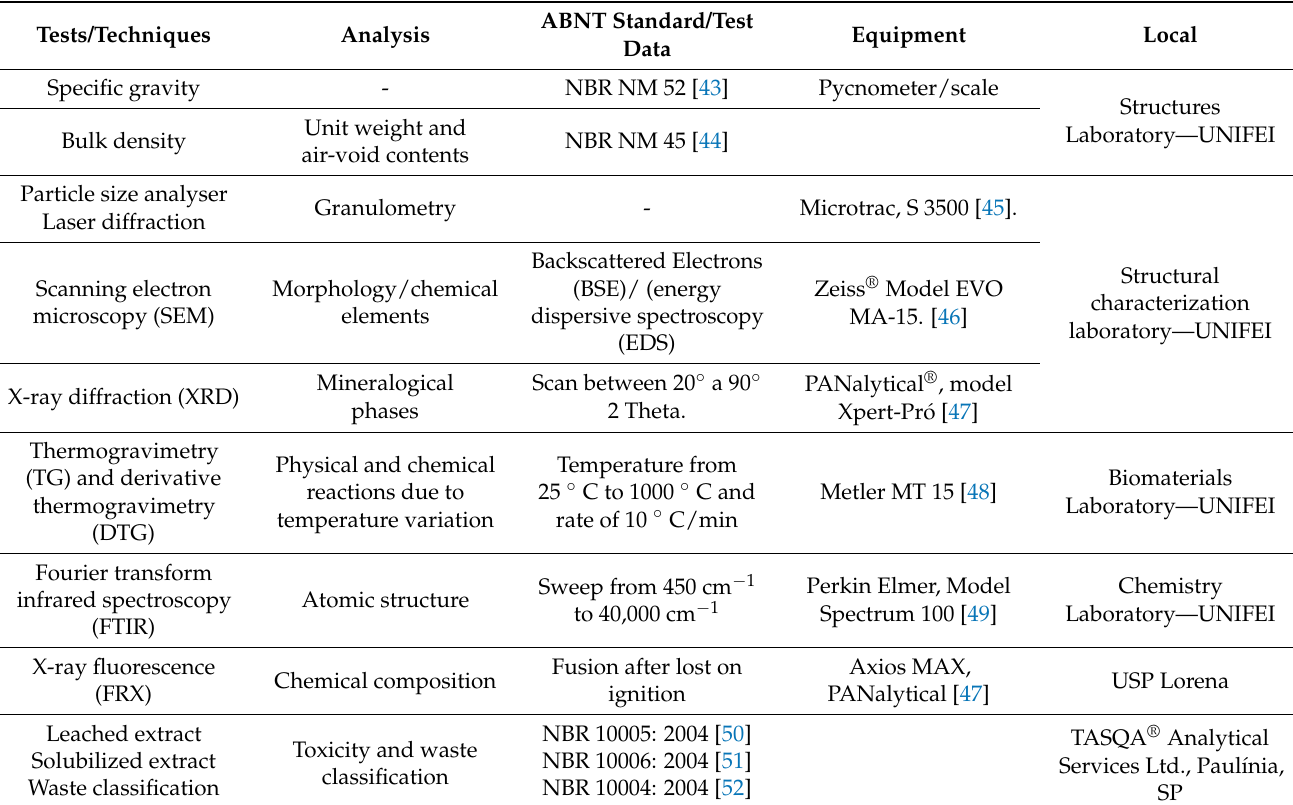
Table 1. Characterization techniques applied to WFES